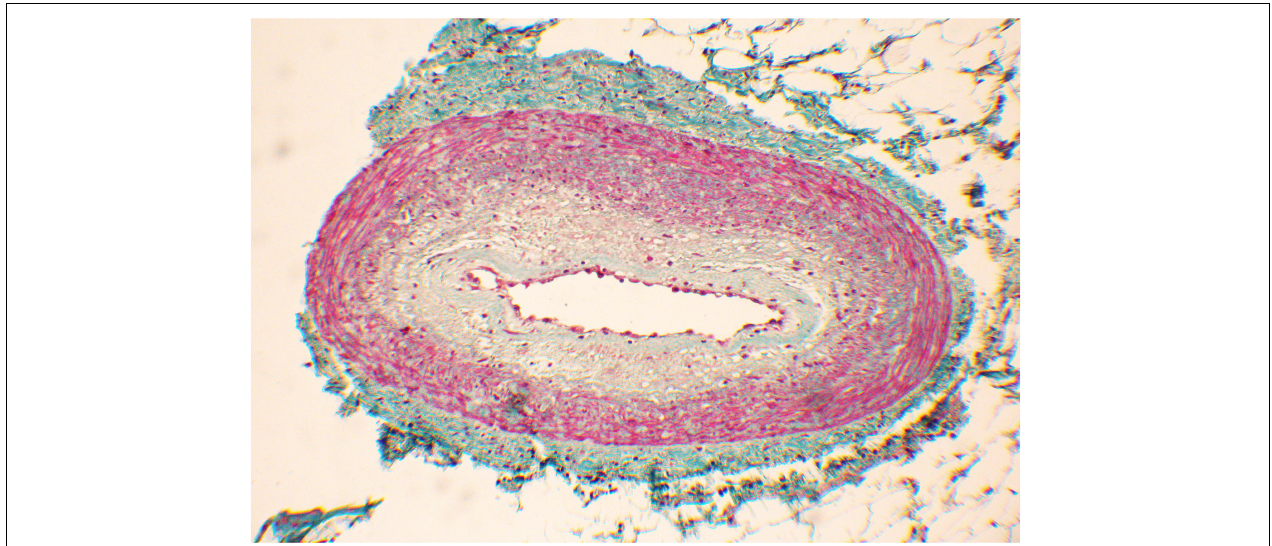
FIGURE 7 | Subendothelial fibrosis of epicardial coronary artery found within the irradiated